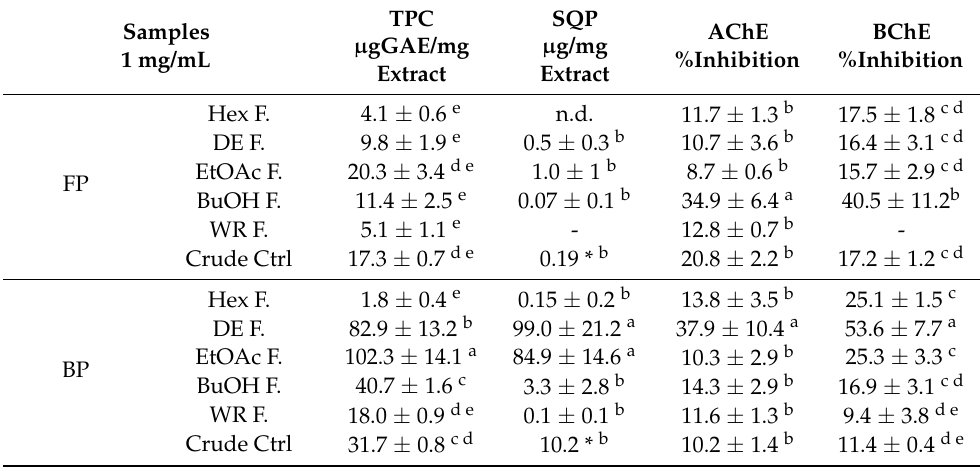
Table 3. Total phenolic content (TPC), sum of quantified polyphenols (SQP) of free phenolic (FP) and bound phenolic (BP) extracts and their anticholinesterase activities in different solvent fractions tested at 1 mg/mL.